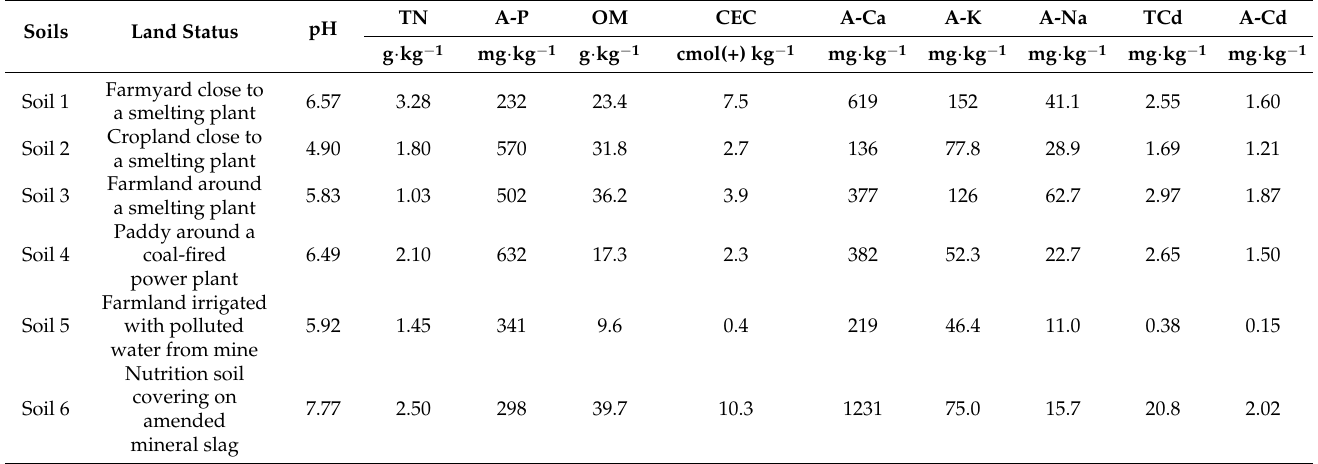
Table 1. Characteristics of six experimental